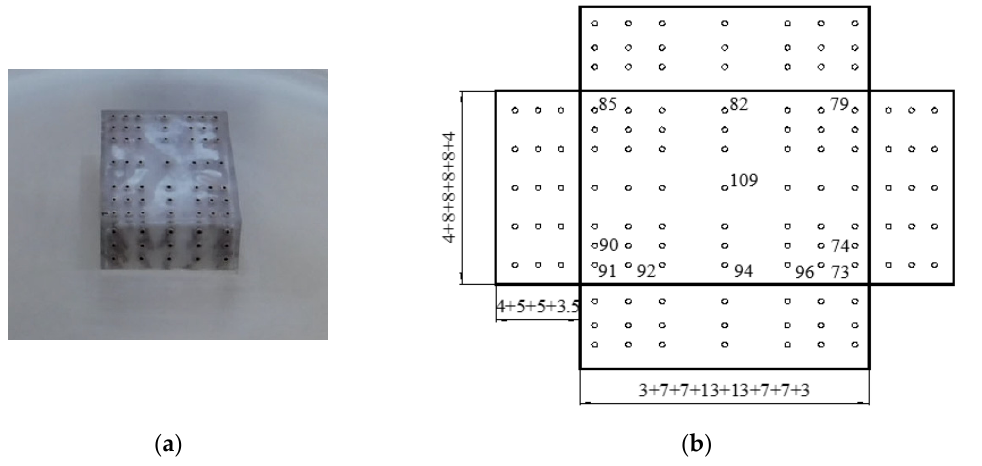
Figure 3. Building model and distribution of pressure taps. ( a ) Building model and ( b ) distribution of pressure taps. Some numbered taps that may be mentioned later are tagged.